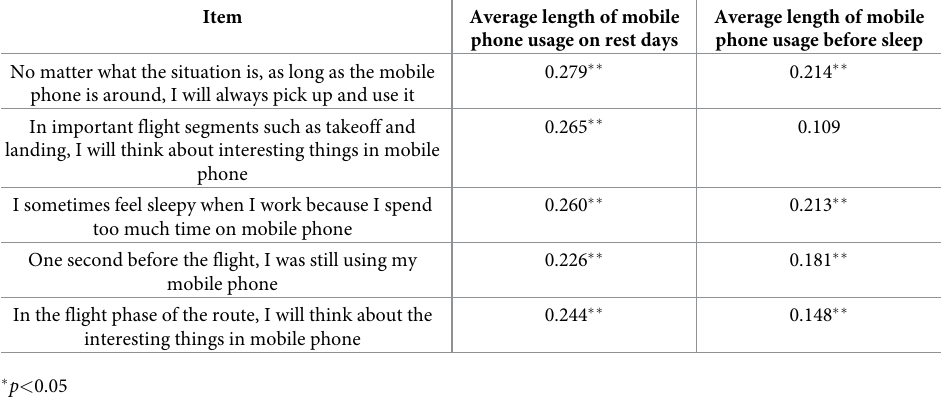
Table 10. Pearson Correlation Coefficient between mobile phone usage duration and flight